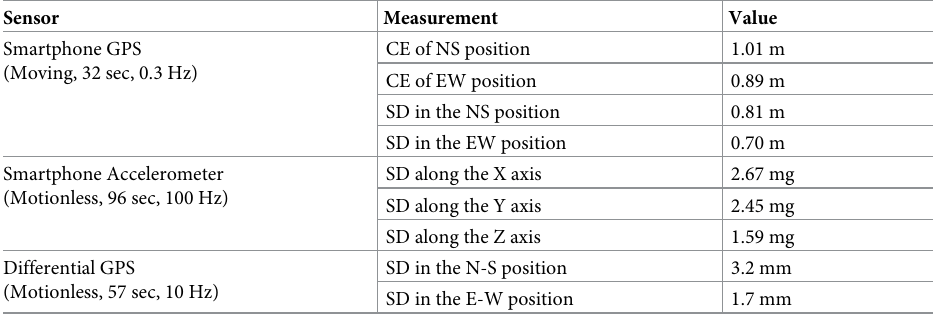
Table 1. Sensor measurement accuracy and precision. The rows corresponding to the smartphone GPS provide the accuracy (central error, CE [2]) and precision (standard deviation, SD) of the GPS-derived position relative to simulta- neously collected DGPS position of the moving pair of sensors (see the following section for our definitions of these statistics). The smartphone accelerometer rows provide a measure of precision of the sensor’s body fixed acceleration when the smartphone is motionless. Similarly, the differential GPS rows provide a measure of precision of the motion- less rower position relative to the motionless base station. The duration of the data logs used to derive these metrics and the frequency at which they were sampled are listed for each